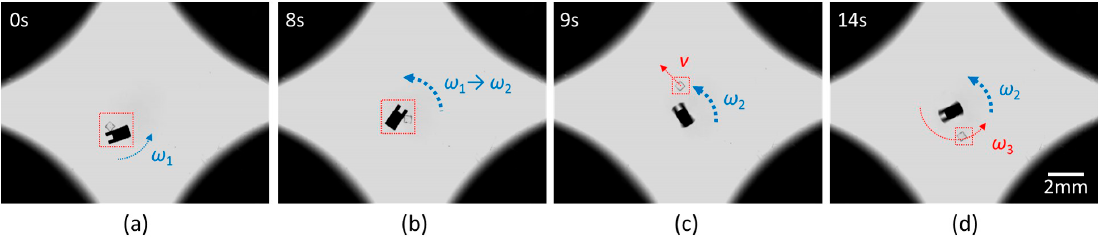
Figure 10. Snapshots of micromodules’ release by high-frequency rotation. ( a ) Angle adjustment of the entirety. ( b ) Increase of the rotational frequency. ( c ) Fly out of the micromodule along the tangent. ( d ) Rotation of the released micromodule caused by the vortex.